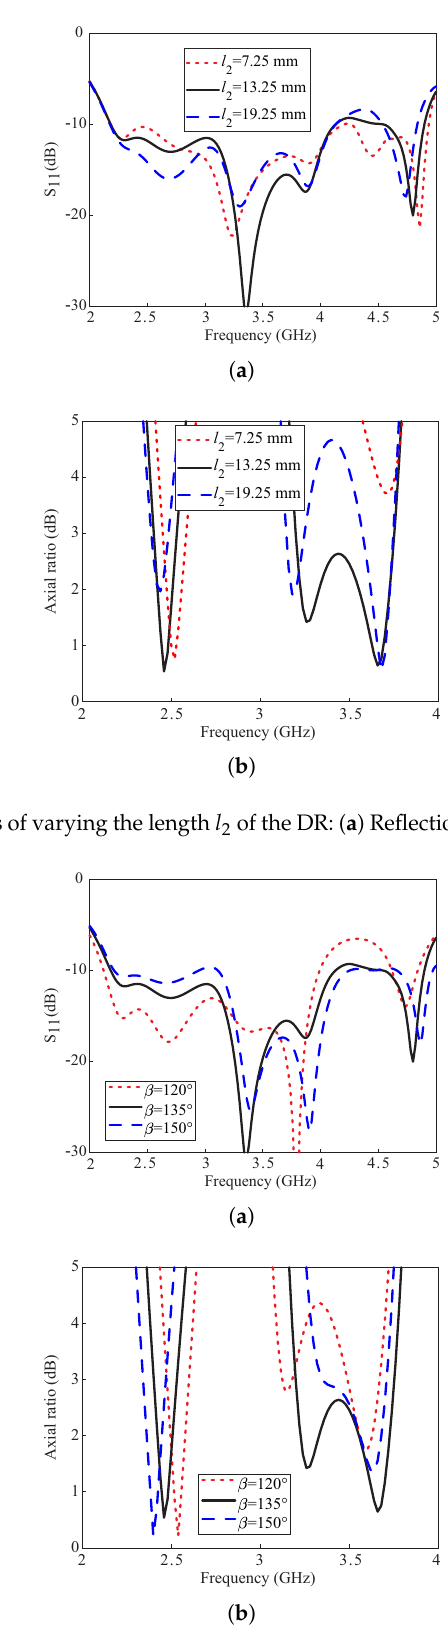
Figure 7. Simulated effects of varying the rotation angle β of the long arm of the DR: ( a ) Reflection coefficients; ( b ) Axial